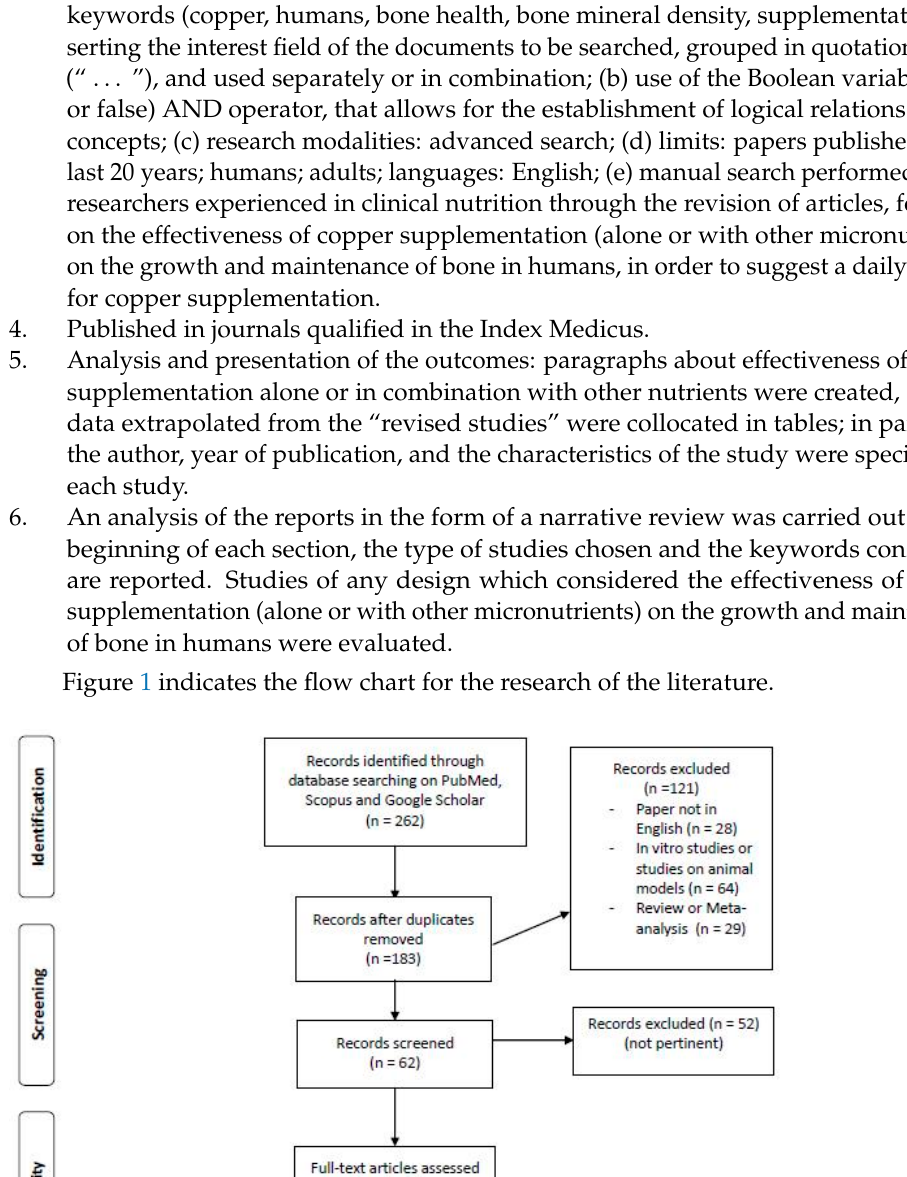
Figure 1. Flow chart for research of the